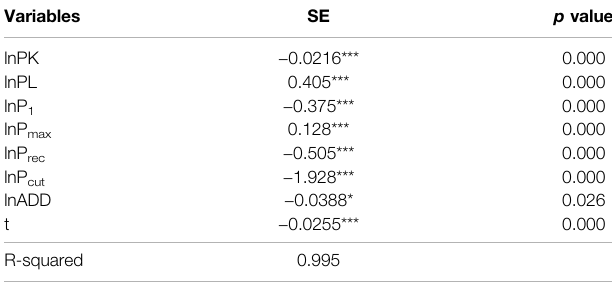
TABLE 4 | The results of electricity cost share with decomposed prices.